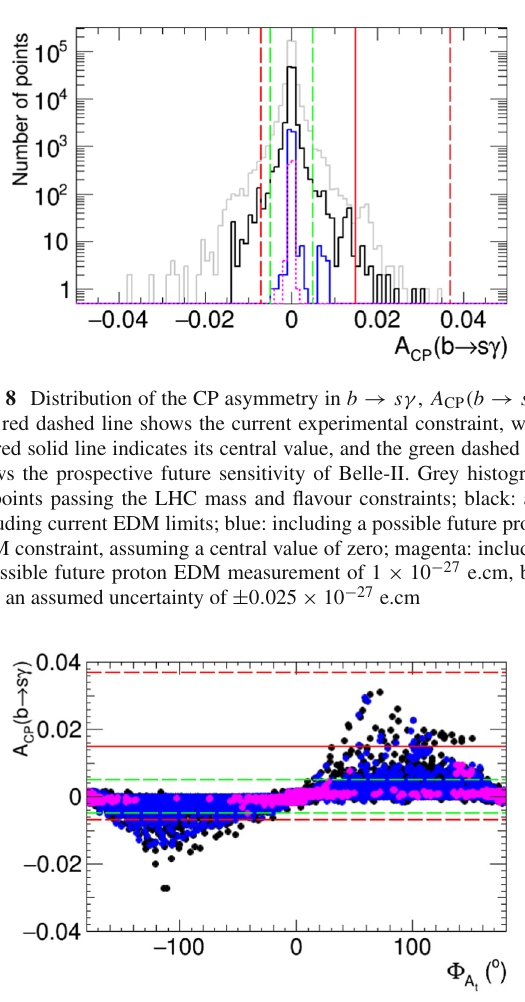
, A ( b → s γ)) plane. Fig. 9 Distribution of scan points in the (φ A CP t The red dashed line shows the current experimental constraint, while the red solid line indicates its central value, and the green dashed line shows the prospective future sensitivity of Belle-II. Black points: all points passing the LHC mass and flavour constraints, as well as current EDM limits; blue: including possible future proton EDM constraint, assuming a central value of zero; magenta: including a possible future proton EDM measurement of 1 × 10 − 27 e.cm, both with an assumed uncertainty of ± 0 . 025 × 10 − 27